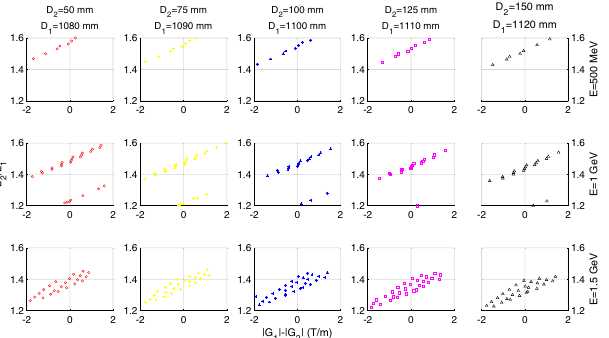
FIG. 5. The ratio of thickness and gradient difference. ( G 1 and G 2 indicate the gradient of Q 1 and Q 2 , L 1 and L 2 are the thickness of Q 1 and Q 2 , D 2 is the drift length between quadru- poles in the triplet, D 1 is the drift length before the first quadrupole in the triplet. In some cases, the distribution is separated into two branches and the lower L 2 =L 1 ones are for thicker quadrupoles, which is not preferred.)